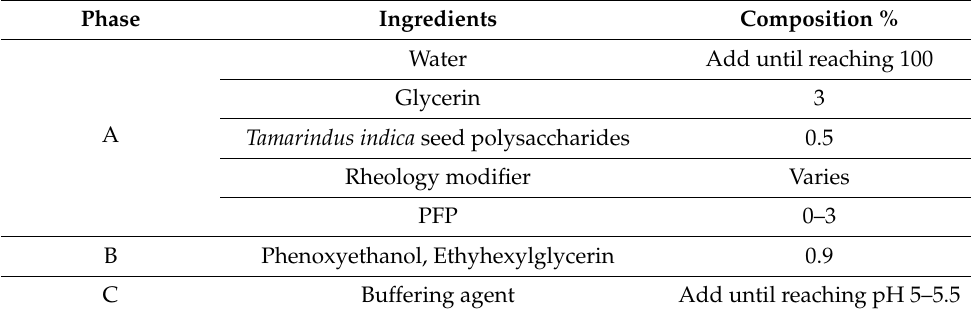
Table 1. Reference formula for gel formulations.